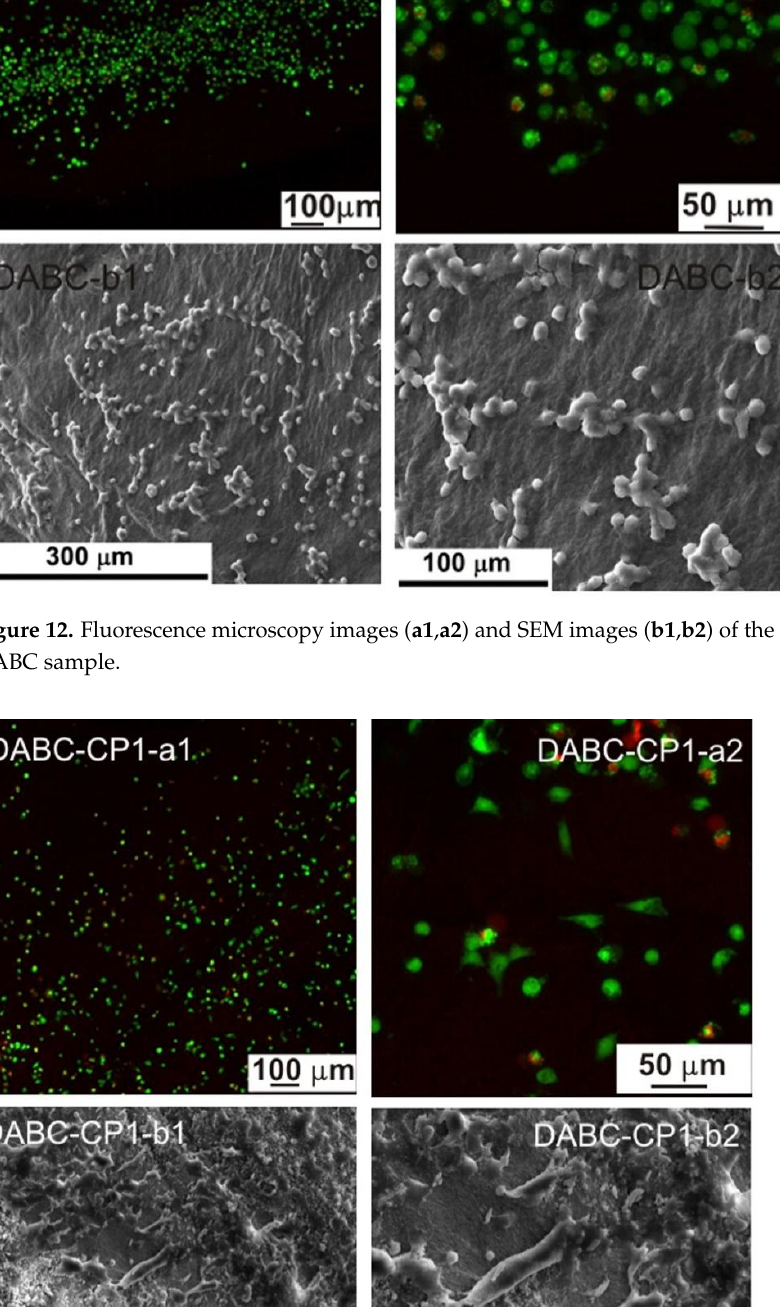
Figure 13. Fluorescence microscopy images ( a1 , a2 ) and SEM images ( b1 , b2 ) of the adherent cells in a DABC ‐ CP1 sample.